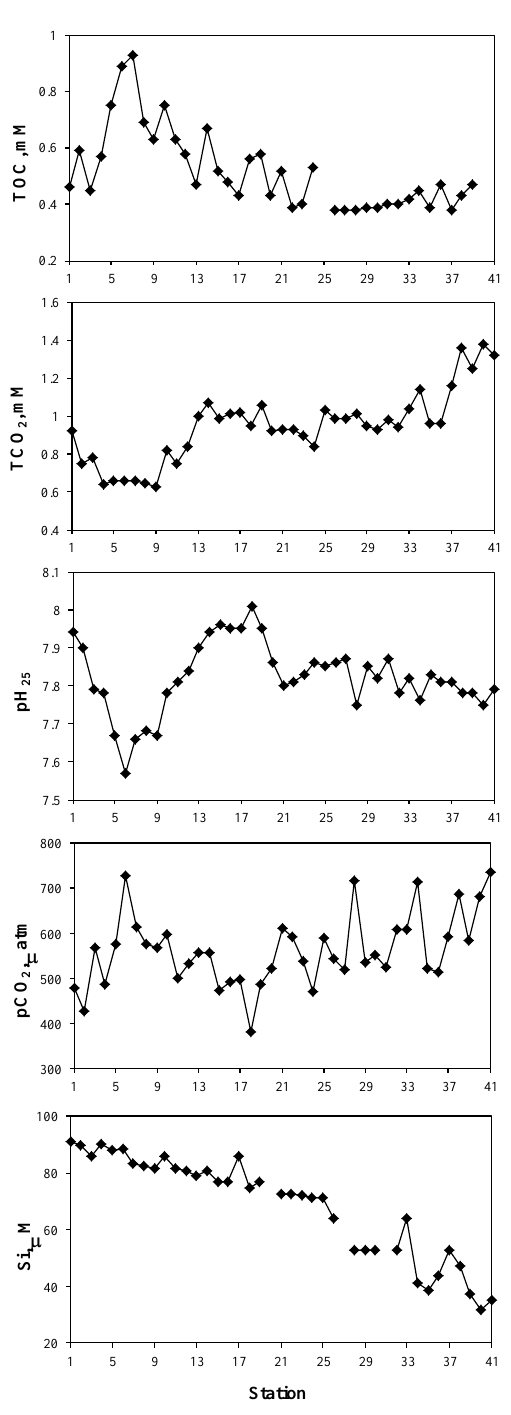
Fig. 5. Distribution of measured TOC, TCO 2 , pH 25 , Si, and p CO 2 along the Lena River from Yakutsk to Tiksi: stations 1–22 (from Yakutsk downstream to the delta, Stolb Island); stations 23–38 (from Stolb Island to the Laptev Sea), late August–early Septem- ber 1995.